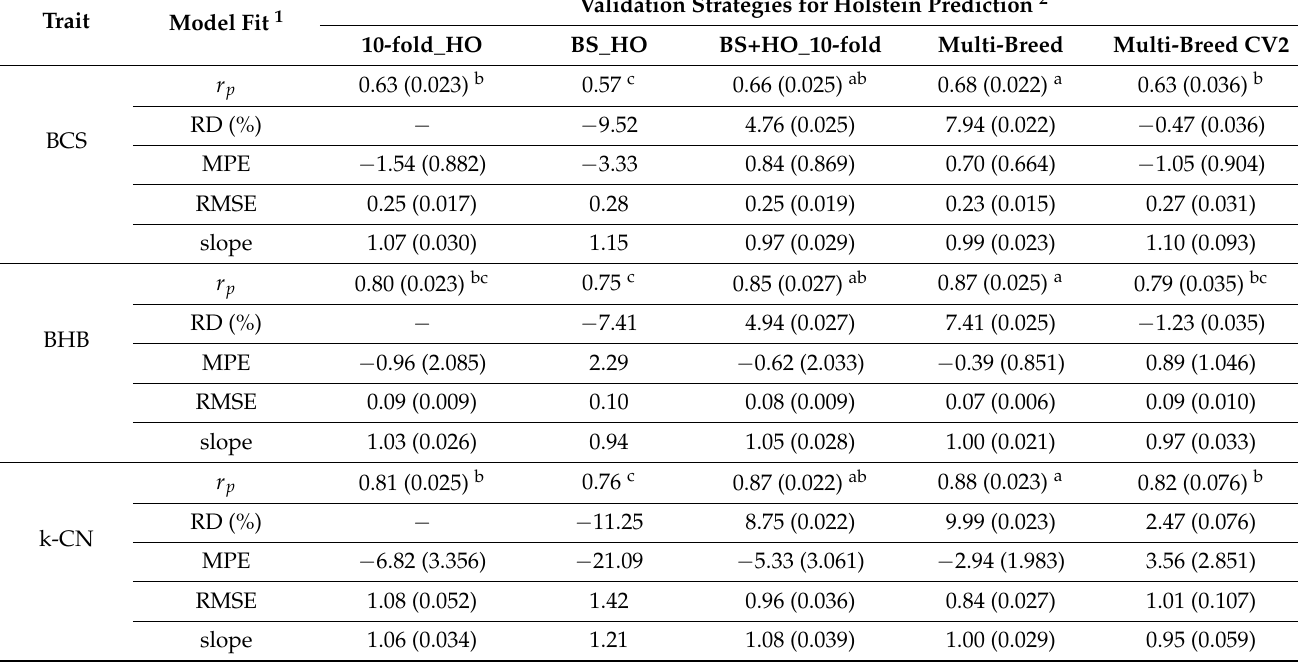
Table 2. Average model predictive performance and its standard deviation values (in parentheses) 1 obtained using gradient boosting machine (GBM) for phenotypic prediction of body condition score (BCS), blood β -hydroxybutyrate (BHB, mmol/L), and kappa casein (k-CN, % N), with the prediction of Holstein Friesian as the final